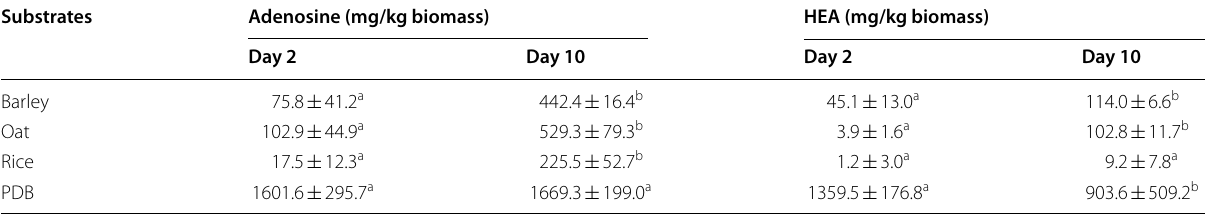
The data is presented as the mean a,b Different letters indicate significantly different values according to a one-way ANOVA with Duncan’s multiple test ( p < 0.05)